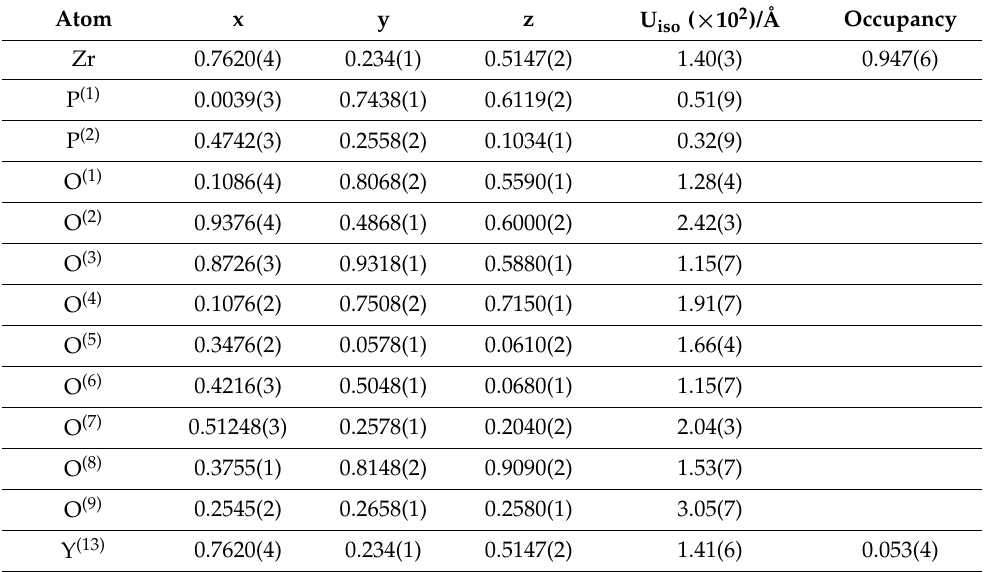
Table 3. Refined fractional atomic coordinates and isotropic thermal displacement parameters for conventionally refluxed 5% Y–ZrP.